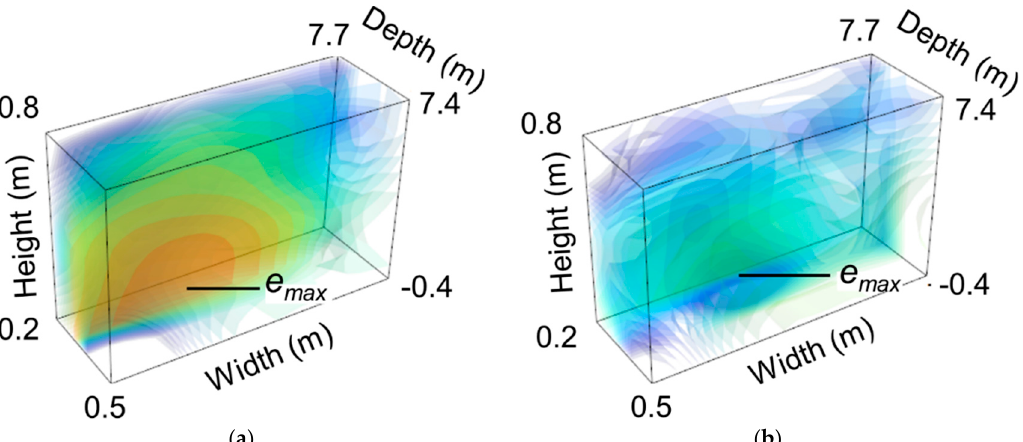
Figure 7. 3D radar images of the zero-power pressure sensor using isosurfaces for applied pressures of ( a ) 1.9 bars and ( b ) 0 bar. Scale: − 50 dB (blue) to − 30 dB (red).